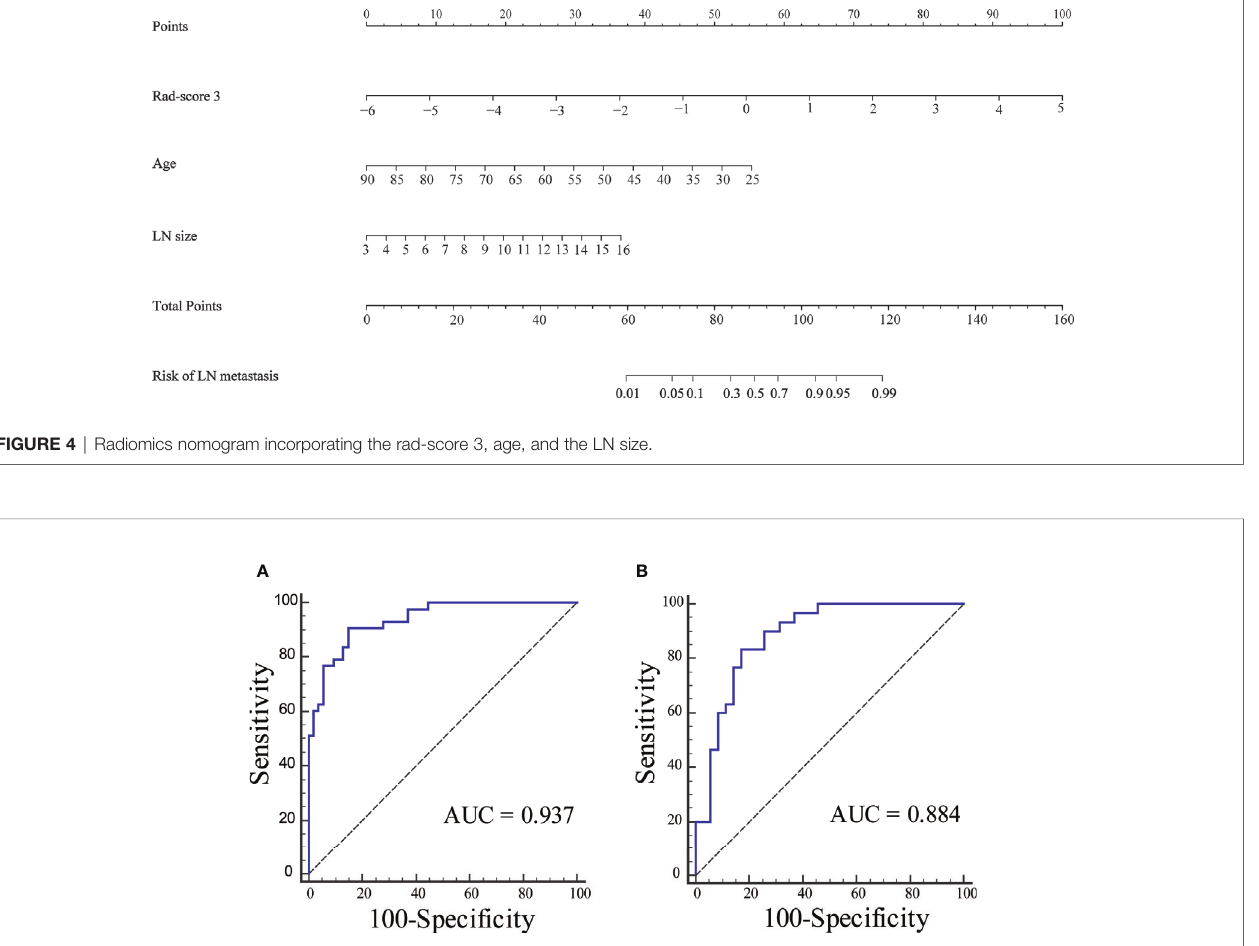
FIGURE 5 | The ROC curves for radiomics nomogram in each cohort. (A) The ROC curve for radiomics nomogram in the training cohort. (B) The ROC curve for radiomics nomogram in the validation cohort.